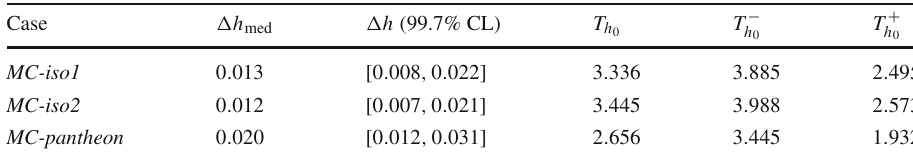
Table 1 Respectively: The MC prescription, the median (cid:6) h , the 99.7% CL limits for (cid:6) h obtained from each case, and the h 0 tension as defined in Eqs. (7)–(8b)